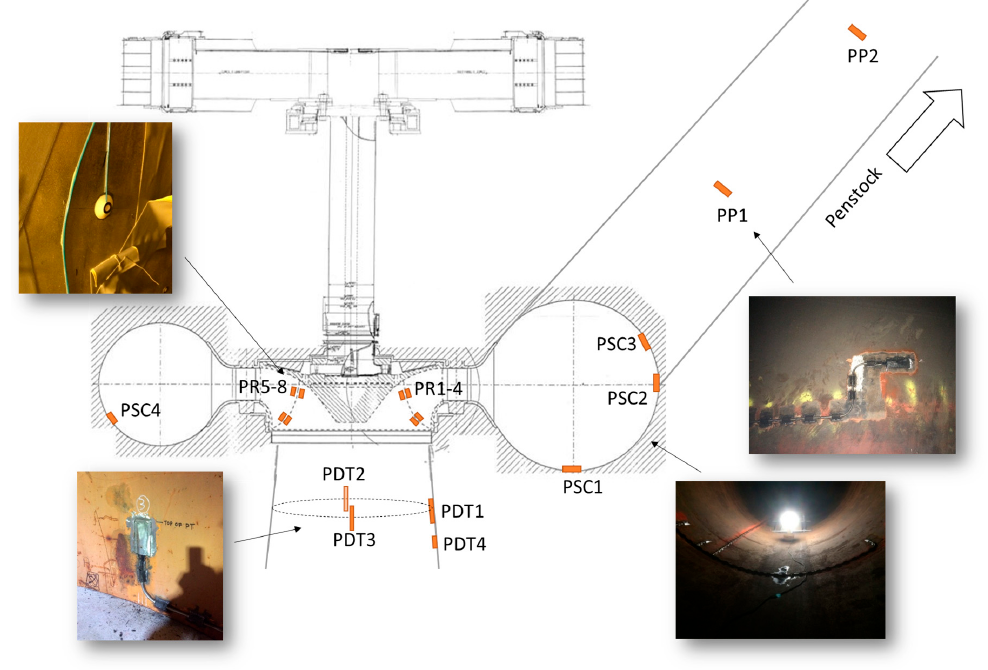
Figure 1. Sketch and pictures of the pressure sensors installed in the prototype.